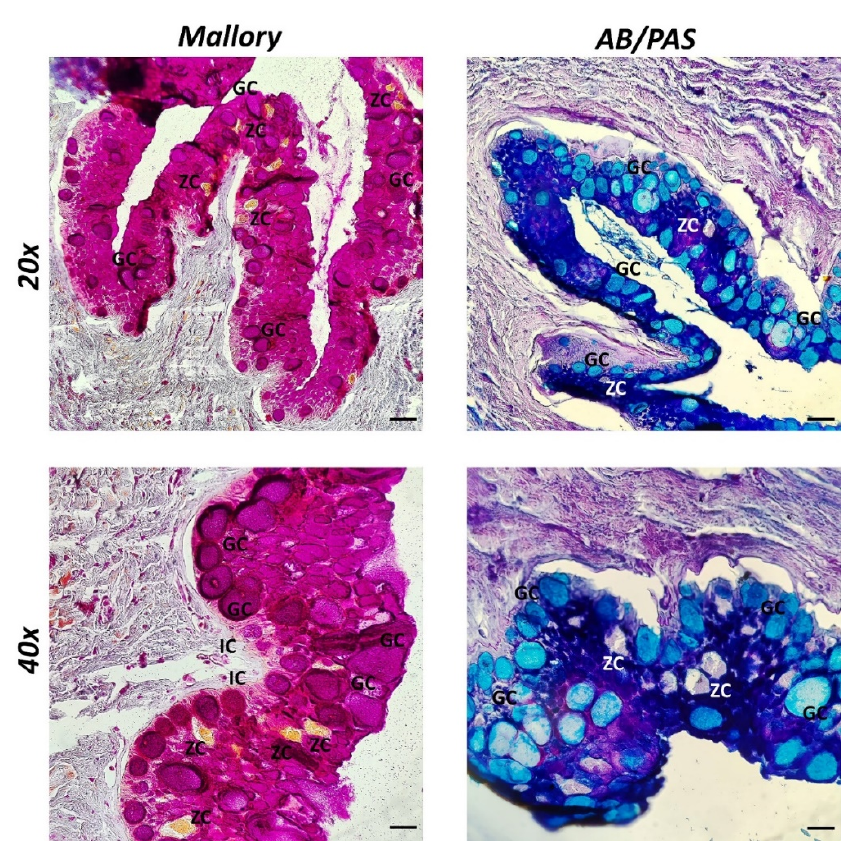
Figure 1. Intestine sections of broadgilled hagfish stained with Mallory Trichrome and AB/PAS, 20× and 40× scale bars of 20 and 40 µm. Zigzag ridges constitute the mucosa, which also contains scattered immune cells (IC) and visible zymogenous cells (ZC). Furthermore, goblet cells (GC) can be identified based on the type of secretion. Numerous ovoid-shaped goblet cells with acidophilic secretion are highlighted in blue by AB/PAS.